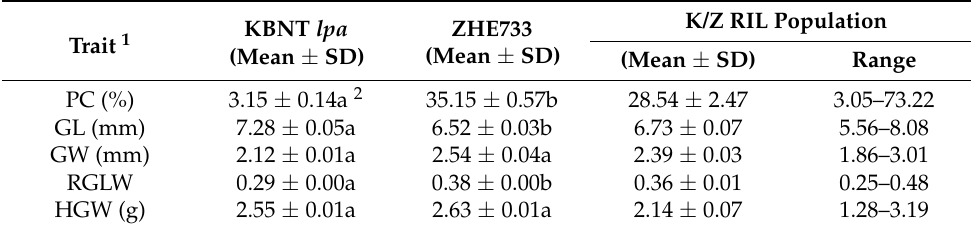
Table 1. Phenotypic values of percent chalk, grain length, grain width, grain length to width ratio, and hundred grain weight of the K/Z RIL population. Trait